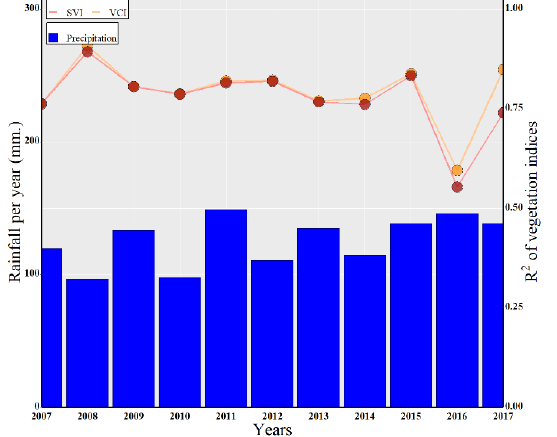
Figure 5. R 2 values of SVI and VCI monthly vegetation indices and rainfall data from 2007 to 2017 in Northeast Thailand.